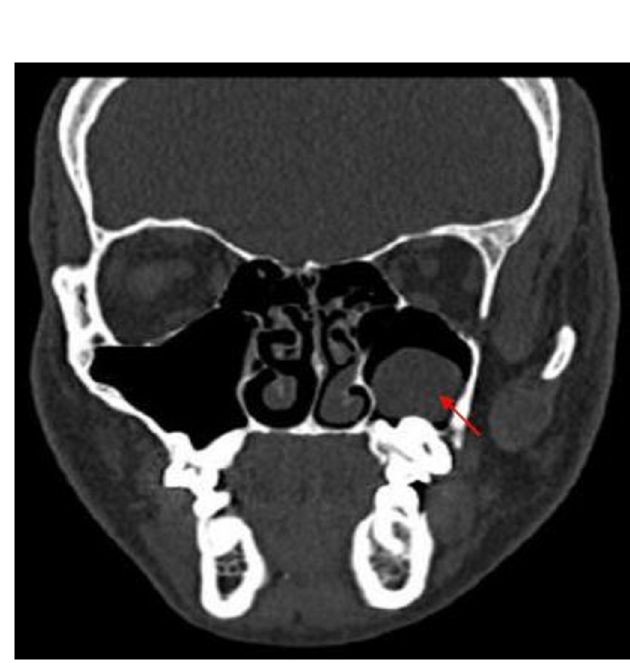
Fig. 3. Postoperative coronal CT image showing unilateral accessory maxillary ostium in the right side of the medial sinus wall (arrow).